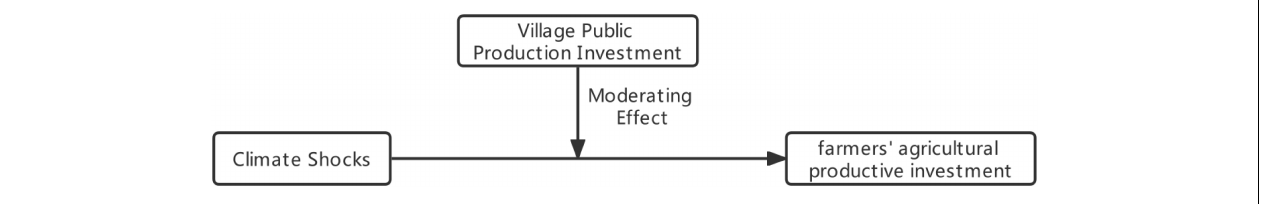
FIGURE 1 | Climate shocks, village public production investment, and farmers’ agricultural productive investment.